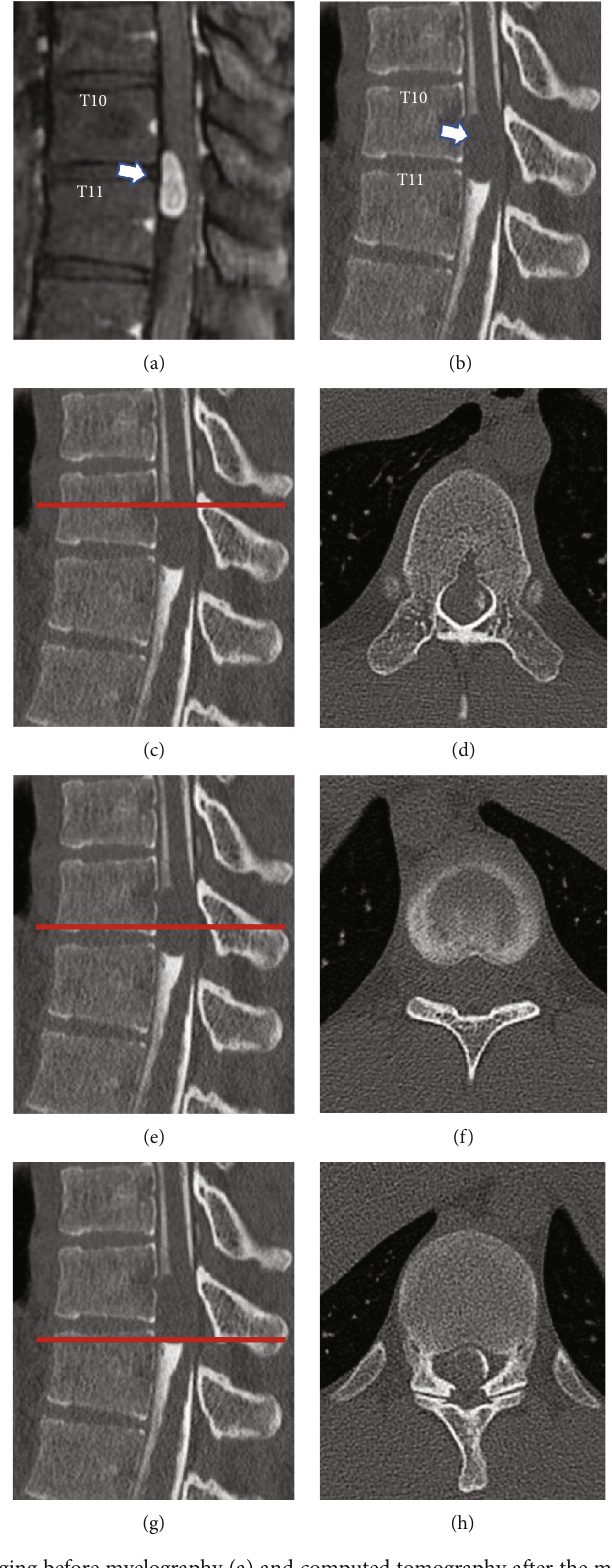
Figure 2: Magnetic resonance imaging before myelography (a) and computed tomography after the myelography (b) shows the intradural mass rostrally migrated with approximately 10 mm discrepancy in the exact location compared to magnetic resonance imaging fi ndings. Arrows indicate the location of the lesion. Each level of axial image on computed tomography shows the proximal (c, d), middle (e, f), and distal (g, h) levels of the